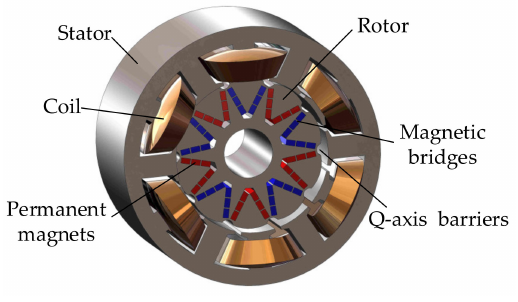
Figure 1. The structure of the